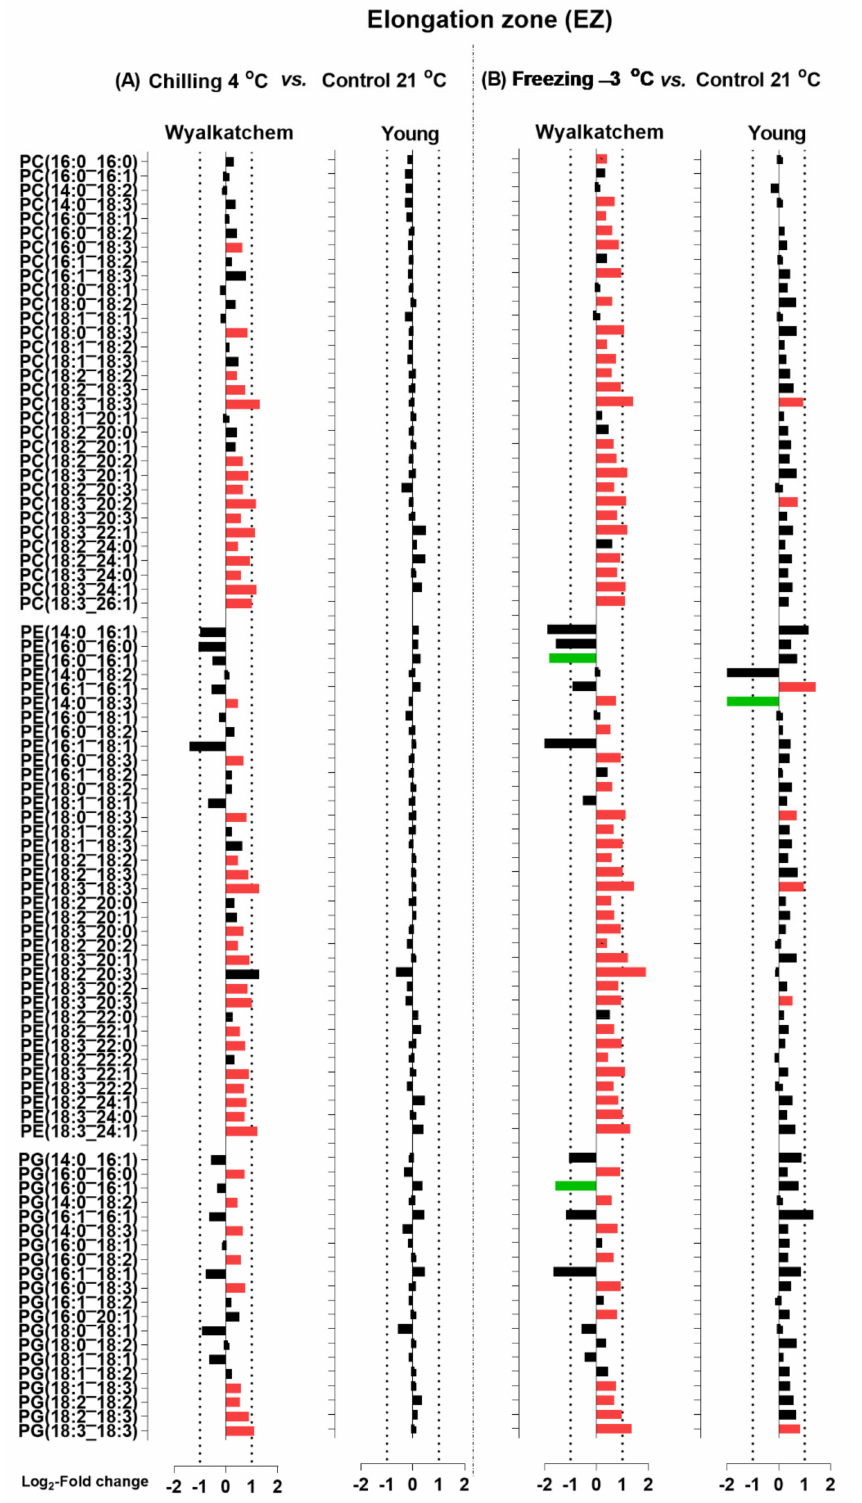
Figure 8. Log 2 -fold changes of PC, PE and PG species in the elongation zone (EZ) of the cold- sensitive Wyalkatchem and cold-tolerant Young after exposed to ( A ) chilling and ( B ) freezing stresses. Statistical significance was determined using an FDR-adjusted p -value of 0.05 as the cut-off. Green bar = significant decrease; Red bar = significant increase. Black bar represents lipid species that has no significant change after cold stress as compared to control. n =